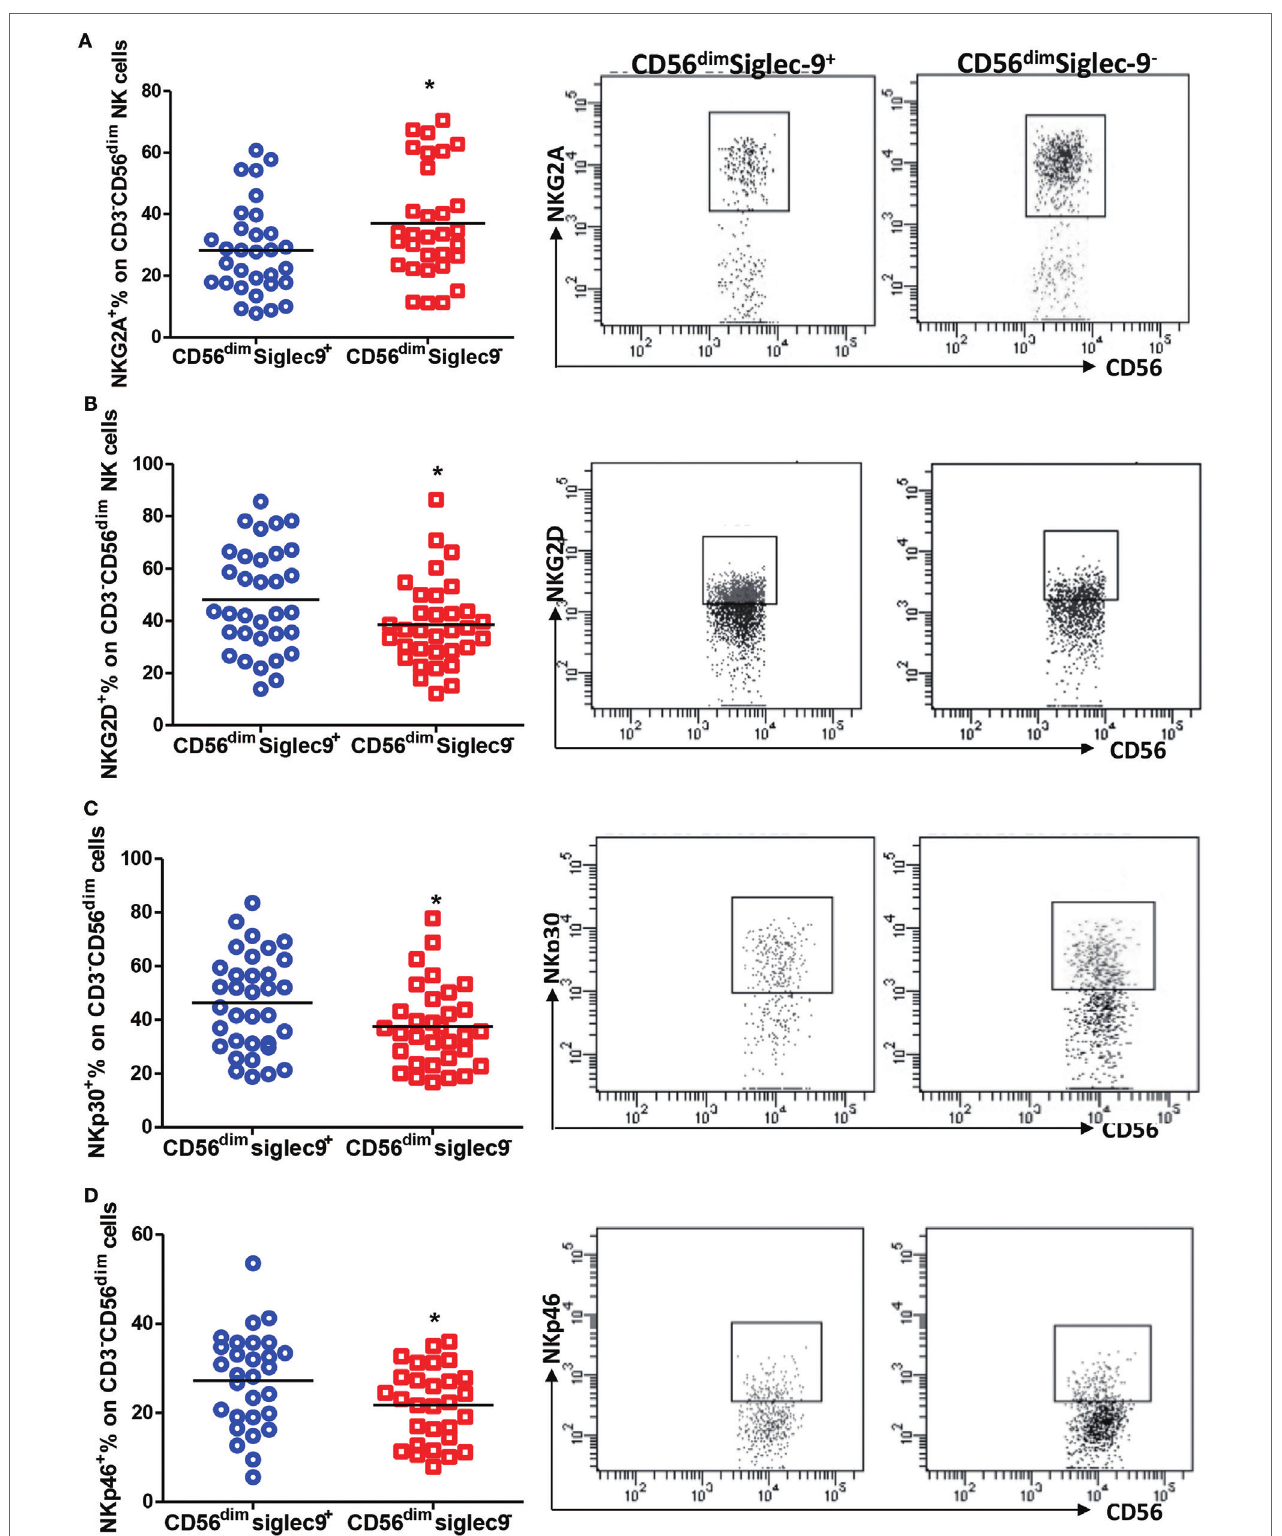
FigUre 4 | Siglec-9 positive NK cells shows more activating phenotype in chronic hepatitis B patients. (a–D) The expression of NKG2A (a) , NKG2D (B) , NKp30 (c) , and NKp46 (D) in Siglec-9 + CD3 − CD56 dim NK cells and Siglec-9 − CD3 − CD56 dim NK cells. Representative dot plots were shown in right